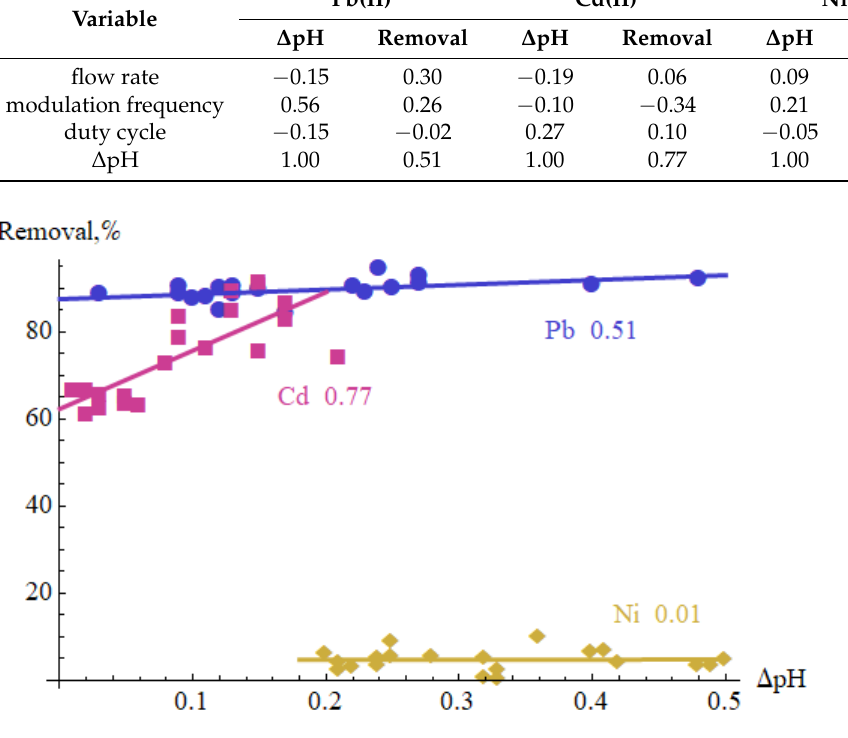
Figure 3. Generator settings optimization results in (ΔpH, Removal) coordinates.